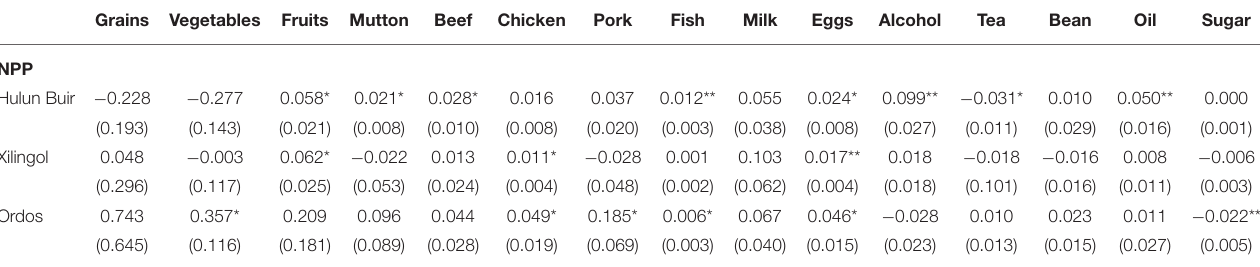
TABLE 9 | Relationships between NPP and food consumption among grassland transects. Grains Vegetables Fruits